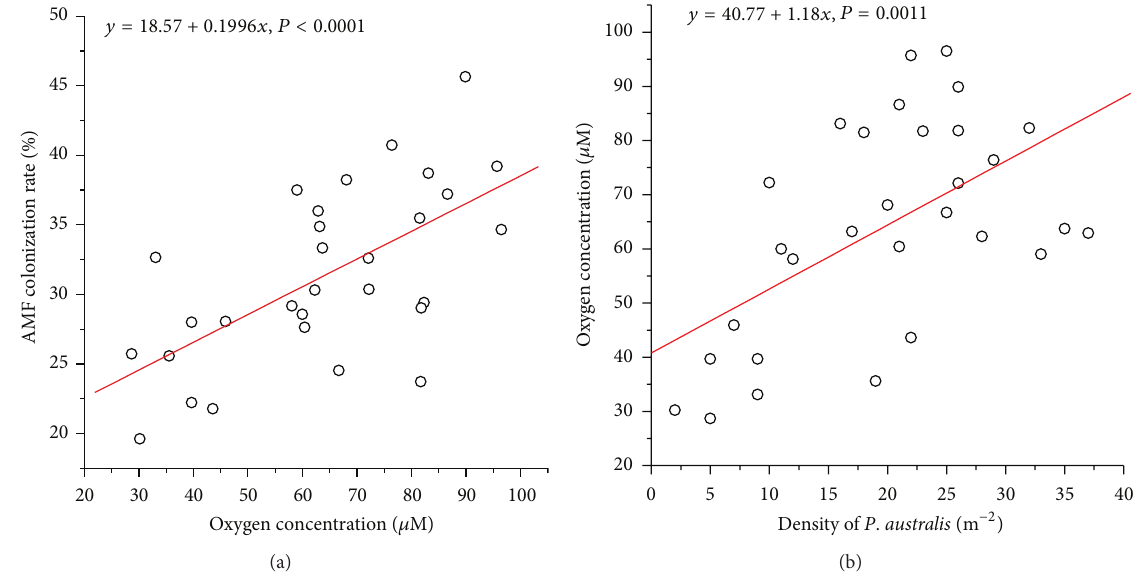
Figure 3: Relationship between the proportion of potential root tissue occupied by mycorrhizal fungus and oxygen concentration (a) and between oxygen concentration and density of P. australis .